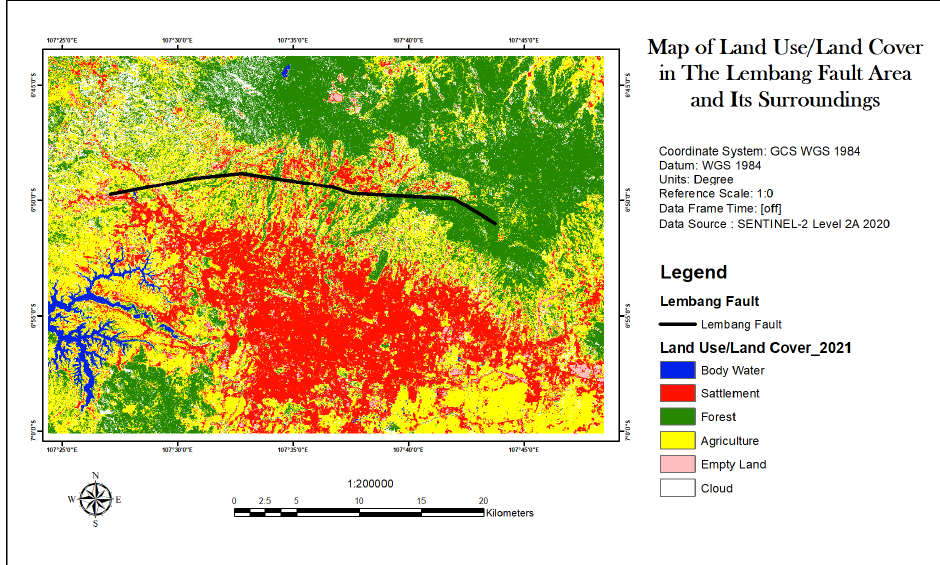
Figure 4. Land use/land cover of the Lembang Fault area in 2021. The coverage of forest between 2020 and 2021 had drastically decreased 116,605 ha, while agricultural land coverage at the same period had increased 35,858 ha. In 2021, the coverage of agricultural land (421,646 ha) was already higher than it of forest (411,644 ha).